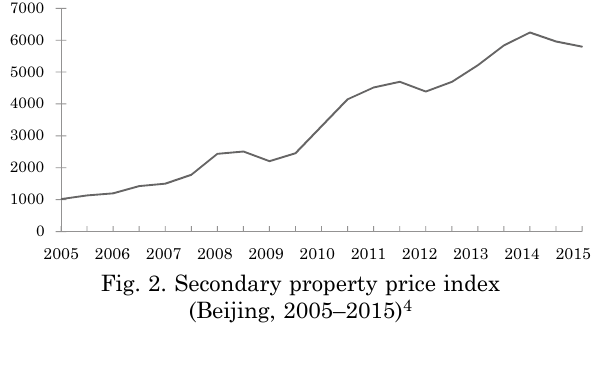
fig. 2. Secondary property price